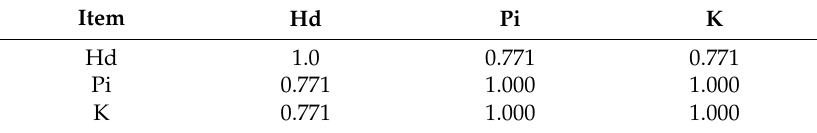
Table 3. Correlation matrix between